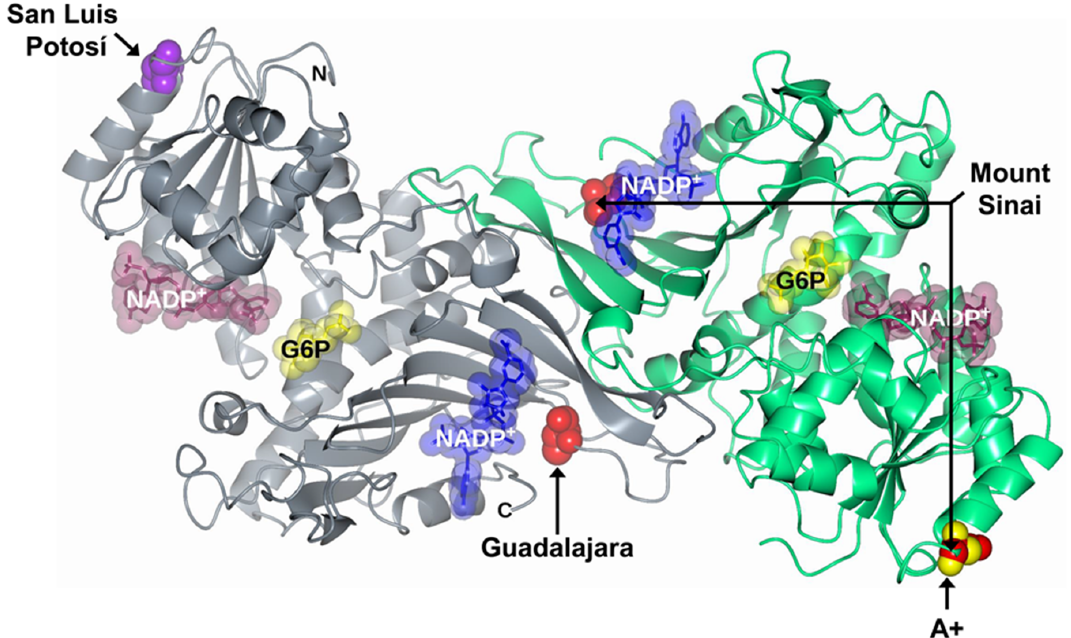
Figure 1. Structure of glucose-6-phosphate dehydrogenase (G6PD) dimer (Protein Data Bank entries 2BHL and 2BH9) indicating location of Class I mutations Guadalajara (R387C) and Mount Sinai (N126D + R387C) (red spheres), Class II mutation San Luis Potosi (N126Y) (purple spheres), and Class III mutation A+ (N126D) (yellow spheres). Structural nicotinamide adenine dinucleotide phosphate (NADP+), catalytic NADP+, and glucose-6-phosphate (G6P) are drawn in blue, dark purple, and yellow molecular surface representations, respectively. Monomers are shown in slate gray and spring green. Same color code is used in all other figures.